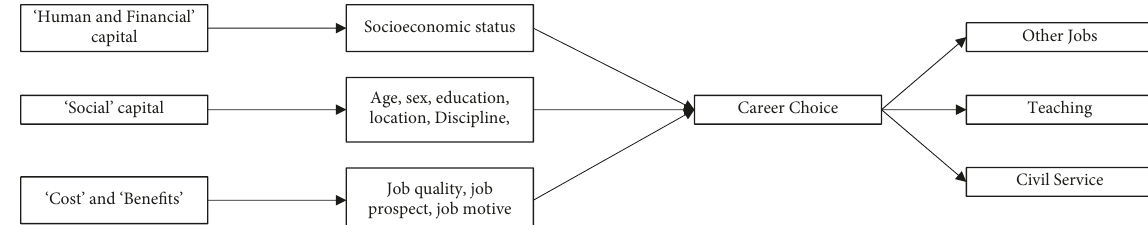
Figure 1: Conceptual framework based on Coleman’s interpretation of rational choice (1990) and social capital (1988)